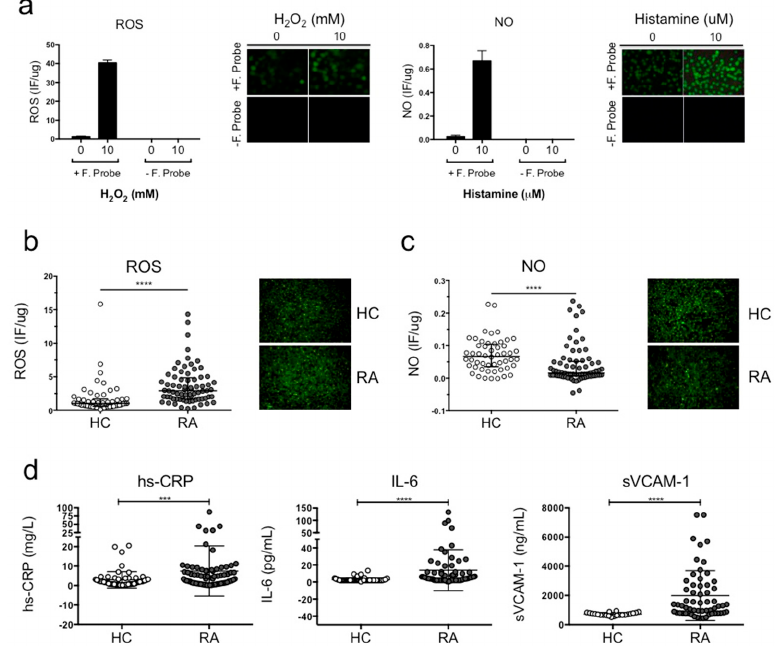
Figure 1. Plasma from RA patients induced increased ROS production and reduced NO synthesis compared to healthy volunteers. ( a ) ECV-304 cells were cultured with 2.5 µ M DCF for ROS and 5 µ M DAF-2DA for 30 min at 37 °C 5% CO 2 in 199 media. The baseline for fluorescence intensity was determined using ECV-304 cells without stimulation. The positive fluorescence signal was obtained using 10 mM H 2 O 2 stimulation for intracellular ROS and 10 µ M histamine stimulation for intracellular NO. ( b ) ROS production and ( c ) NO synthesis was measured in ECV-304 cells cultured with plasma from RA patients and healthy volunteers after 12 h of incubation. Fluorescence intensity was measured using a microplate reader at emission 540 nm (excitation 485 nm) and confirmed by fluorescent microscope. ( d ) Protein concentration of hs-CRP, IL-6 and sVCAM-1 in plasma from RA patients and healthy controls was measured using a chemiluminescent immunometric solid phase assay and ELISA. Mann-Whitney test was used to compare RA patients and healthy controls, *** P < 0.0005